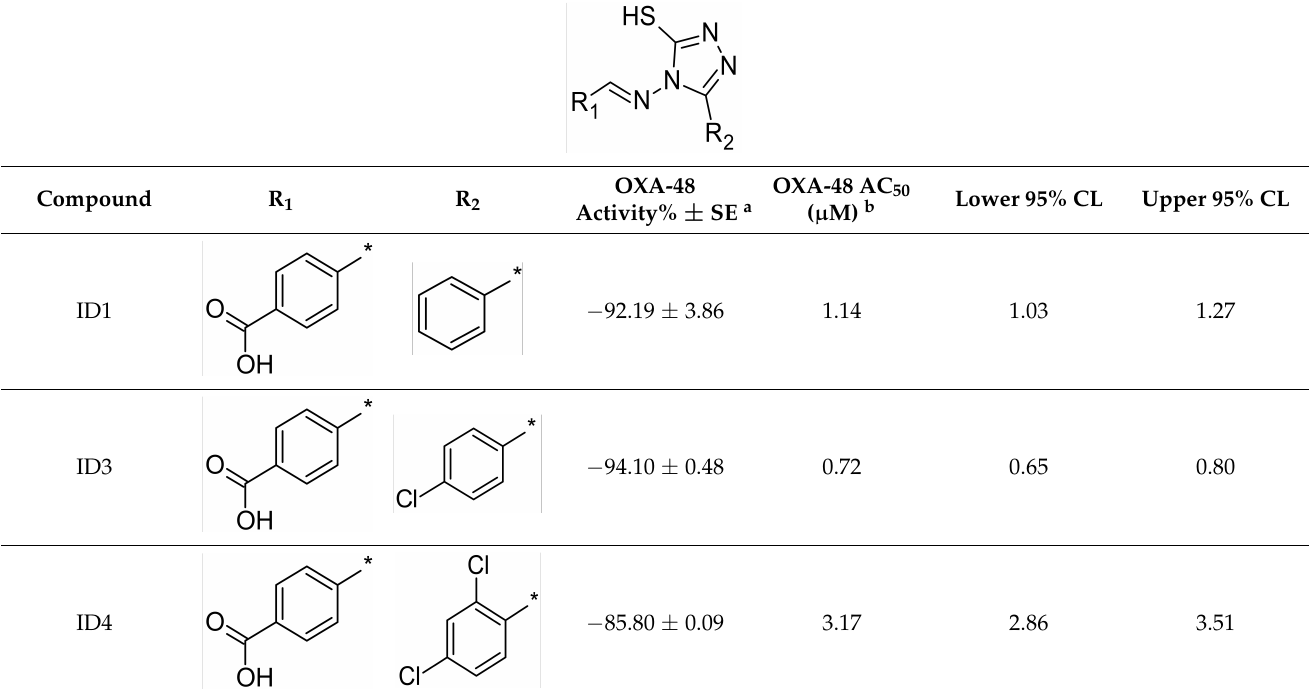
Table 4. SAR Exploration at R 1 and R 2 positions of the 4-Ideneamino 4H-1,2,4-triazole-3-thiol Core.